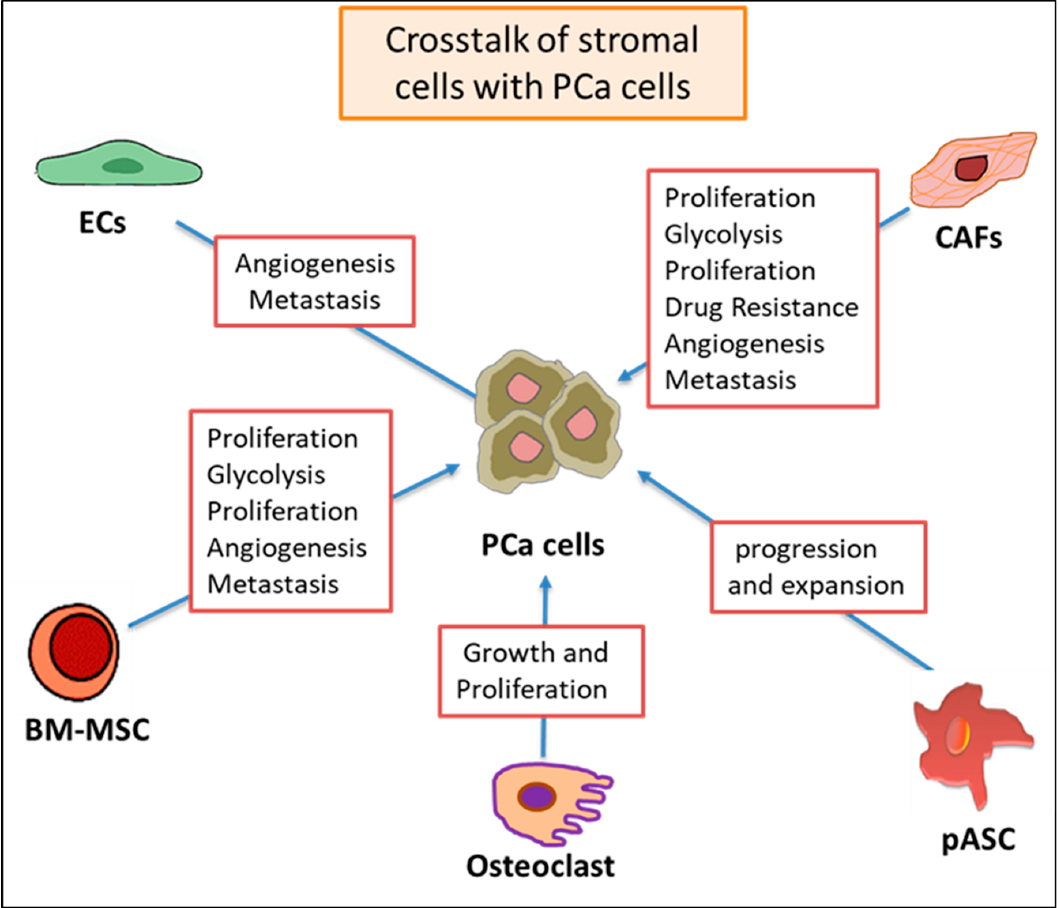
Figure 3. Effect of stromal cell-derived exosomes on PCa progression and metastasis . Stromal cells release exosomes fully loaded with cargo macromolecules to promote cell proliferation, hypoxic and adaptive metabolic pathways, angiogenesis and metastasis of PCa cells. Cancer-associate fibroblasts (CAFs), endothelial cells (ECs), patient adipose-derived stem cells (pASCs), bone marrow-mesenchymal stem cells (BM-MSC) and osteoclast cells. Part of this figure was prepared by the aid of Mind the GRAPH program.